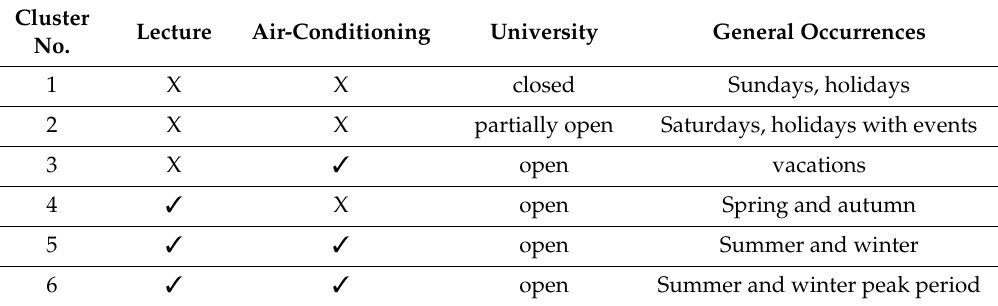
Table 4. Characteristics of electricity use at Chubu